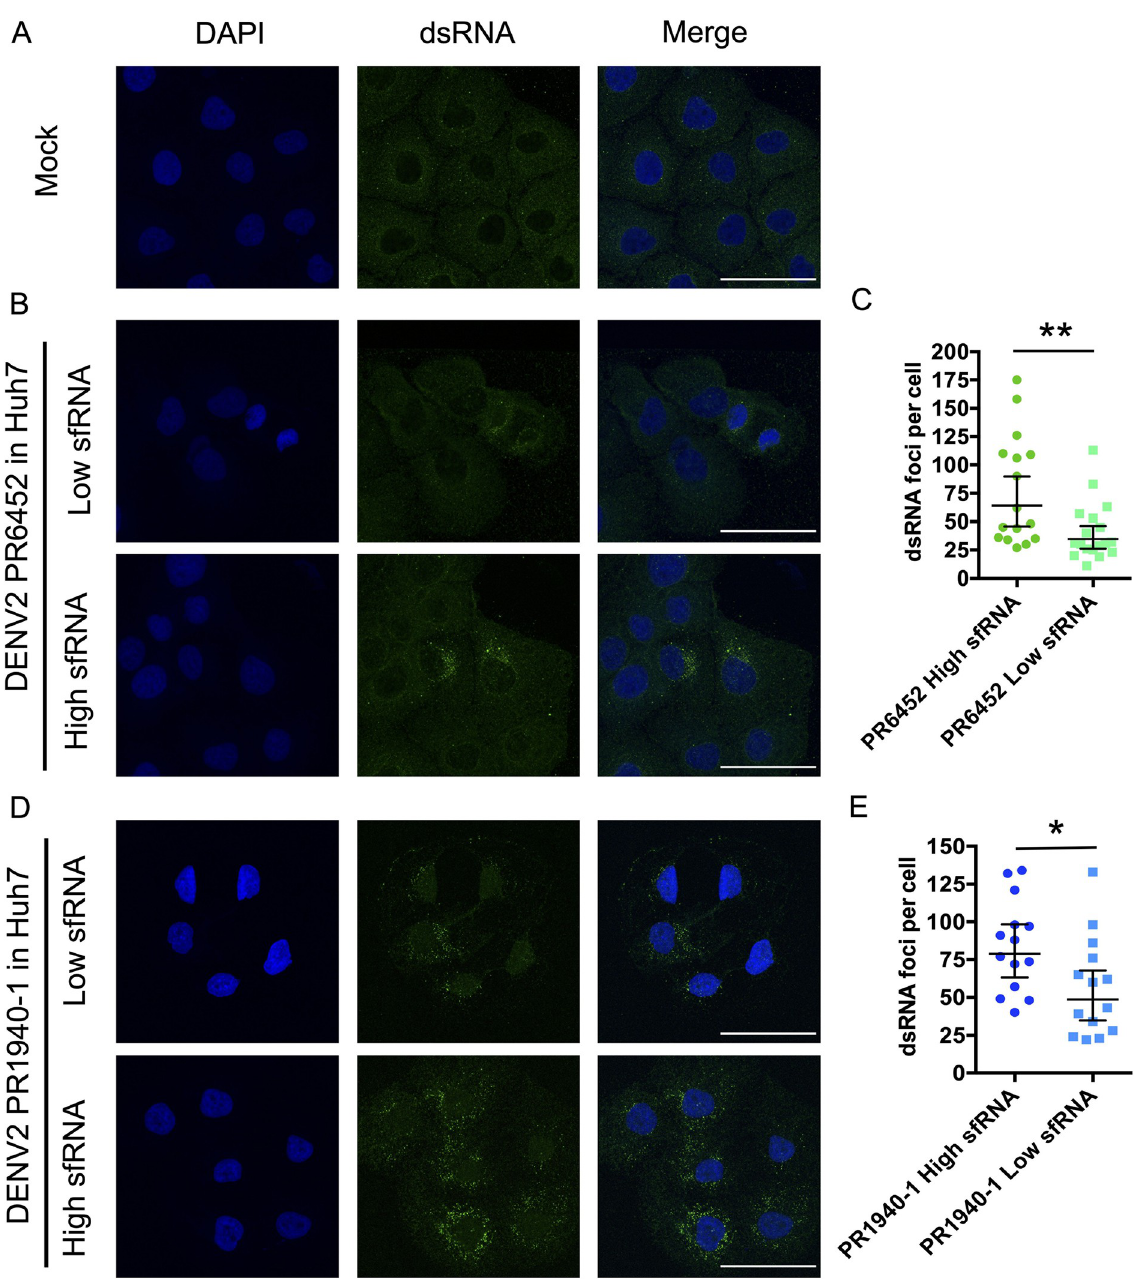
Fig 4. Higher sfRNA:gRNA ratio in mosquito saliva increases DENV2 infection. ( A ) Representative pictures of nucleus (DAPI, blue) and dsRNA (green) from Huh-7 cells supplemented with uninfected saliva. ( B-E ) Representative pictures of nucleus and dsRNA from ( B, D ) and number of dsRNA foci per ( C, E ) Huh-7 cell supplemented with saliva infected with DENV2 PR6452 or PR1940 containing either high or low sfRNA:gRNA ratio. (B, D) Scale bar, 50 μ m. ( C, E ) Each point indicates dsRNA foci in one cell. Bars show geometric means ± 95% C.I. � , p- value < 0.05; �� , p-value < 0.01 as determined using a Mann-Whitney U test.